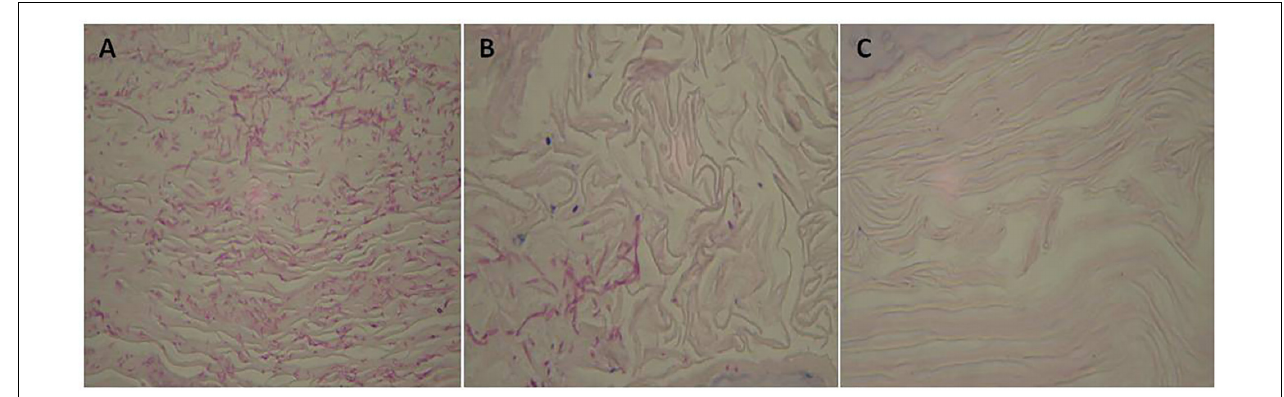
FIGURE 7 | Histological sections of vaginal canal from BALB/c female mice infected intravaginally with 3 × 10 5 C. albicans ATCC 10231 yeast cells and treated with a topical cream containing MCZ (2%) or C7a (5%). Animals were treated every 24 h for 7 days, vaginal canals were removed after 8 days of infection. (A) control group, infected animals and treated with vehicle alone, (B) mice infected and treated with MCZ, (C) mice infected and treated with C7a. PAS staining of the tissue sections and 100 × magnification. Representative images of 10 animals per